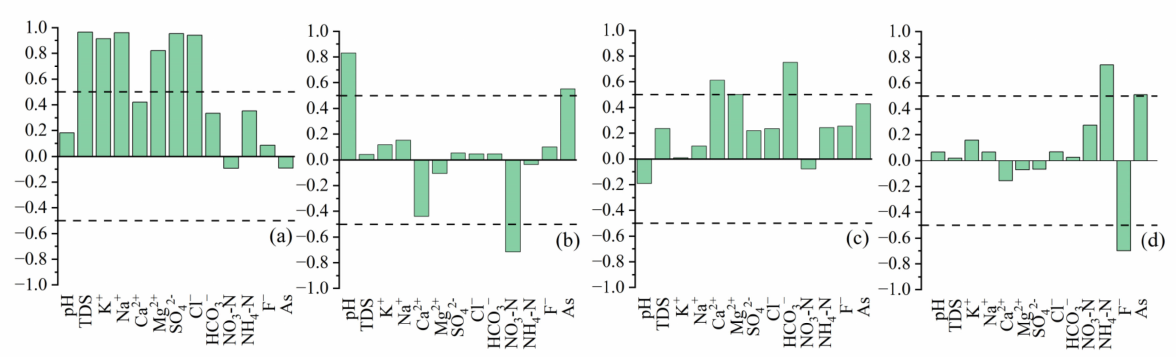
Figure 5. Load factor score of submersible principal component analysis. ( a ) salinity factor; ( b ) alkalinity factor; ( c ) carbonate factor; ( d ) pollution